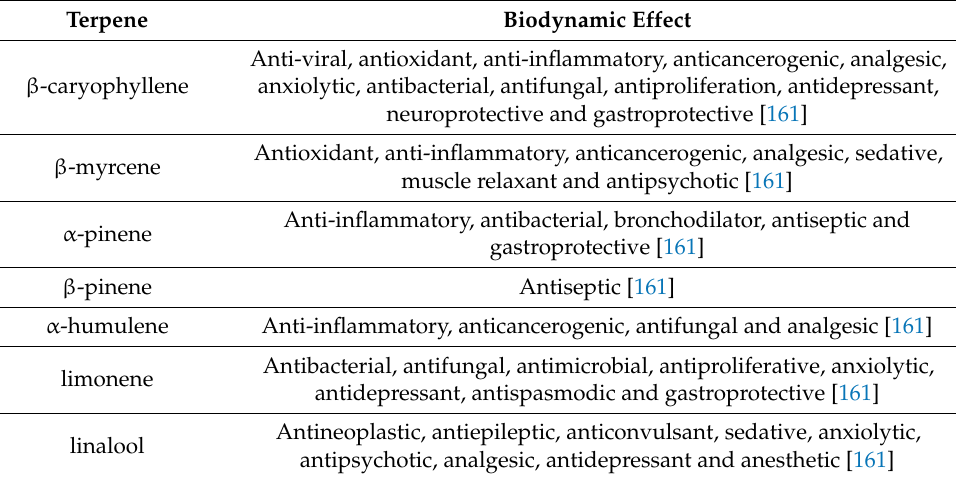
Table 5. Biodynamic effect of the main terpenes found in Cannabis sativa L. Terpene Biodynamic Effect β